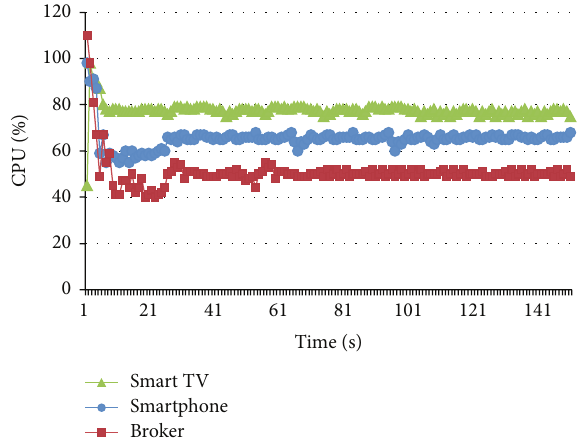
Figure 13: CPU consumption at MST.